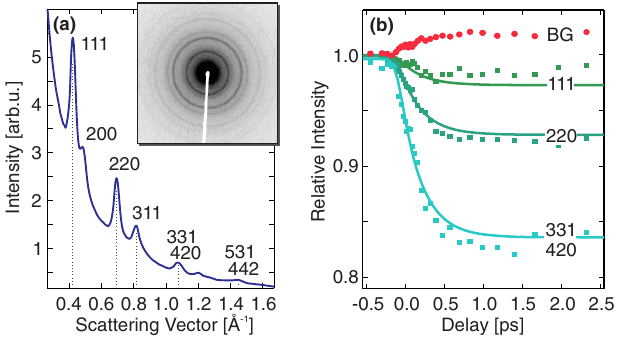
FIG. 2. (a) Diffraction image of 30-nm-thick polycrystalline aluminium (inset) and radial average, retrieved by angular integration. Peaks with multiple labels are too close together to separate experimentally. (b) Evolution of the relative intensity of three selected Bragg peaks and the background (BG) of diffusely scattered electrons with respect to negative time delays for an absorbed energy density of 440 J = cm 3 . The solid lines represent a global fit to the data (see text for